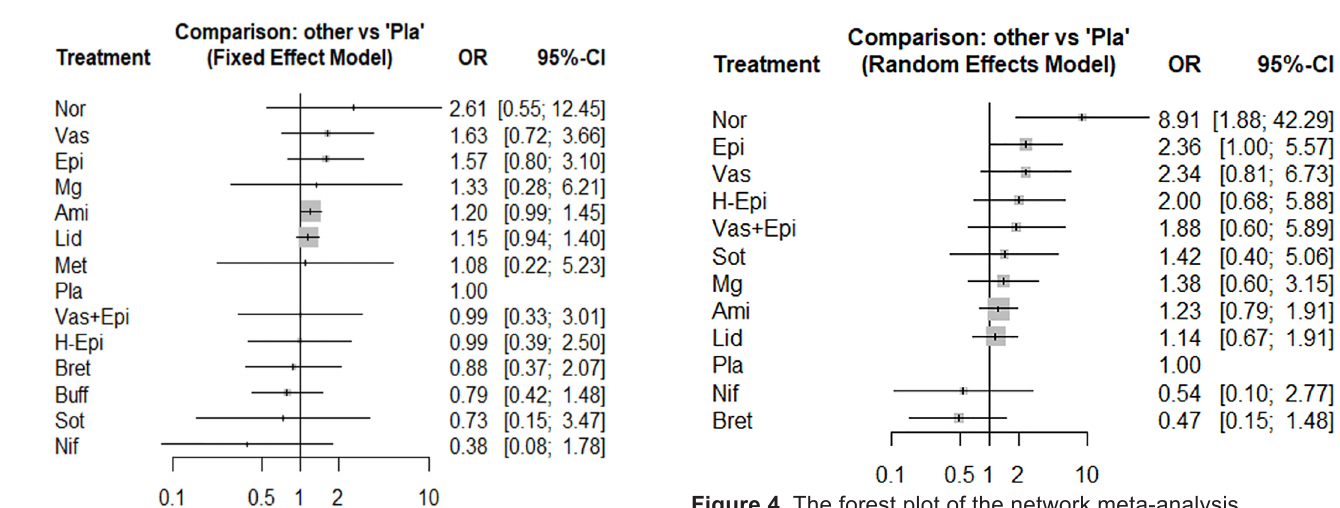
Figure 4. The forest plot of the network meta-analysis comparing the odds ratios on the return of spontaneous circulation among